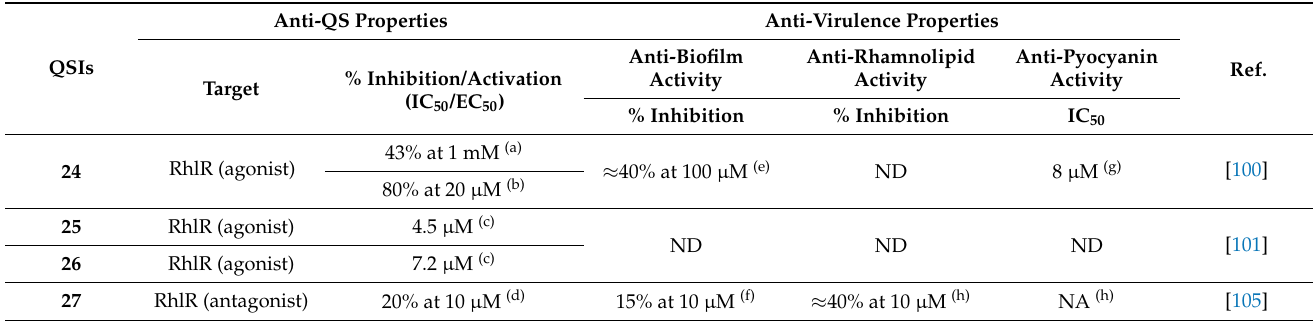
Table 3. Anti-QS and anti-virulence properties of RhlR-modulating QSIs.